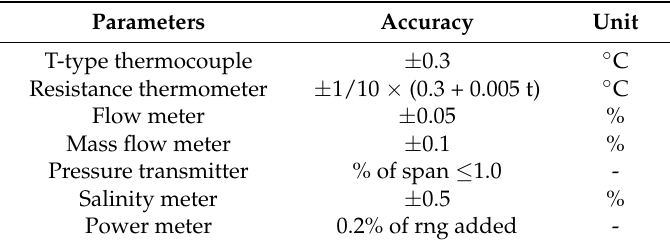
Table 2. Accuracy of measuring instruments.